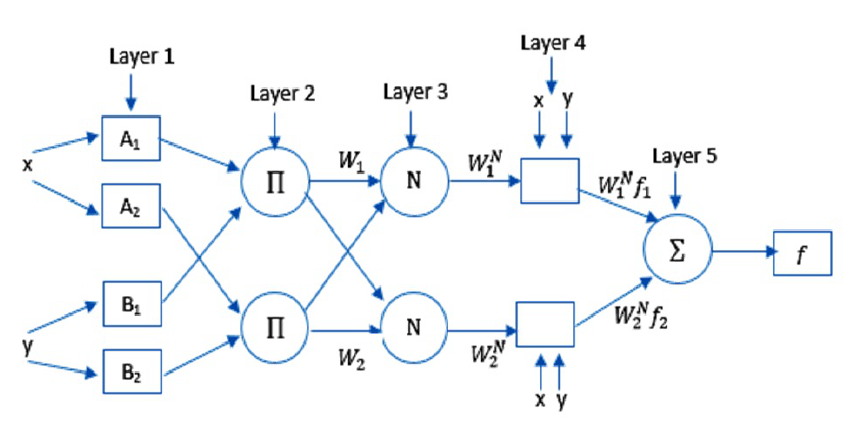
Figure 1. ANFIS model